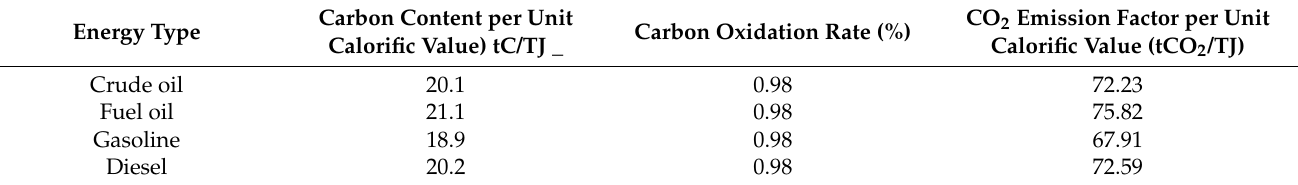
Table 1. Fossil energy carbon emission factor.